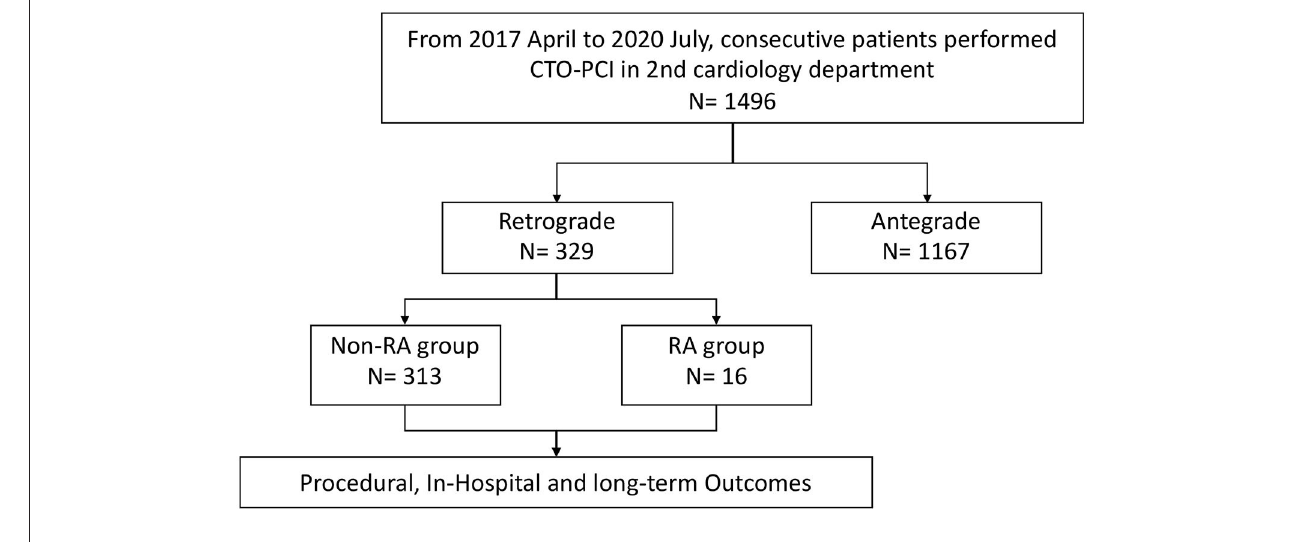
FIGURE 1 | Flow chart of the study population.